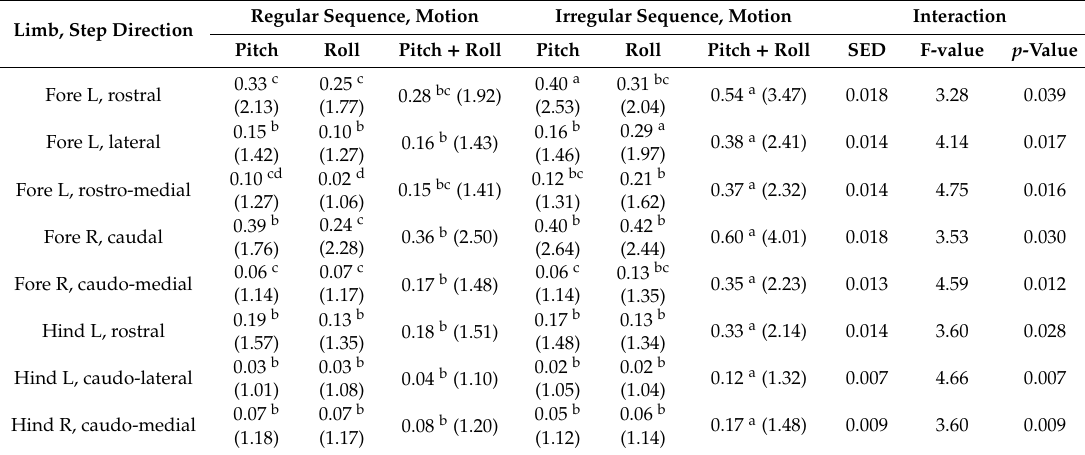
Table A4. E ff ects of regularity and type of motion on the movement patterns of the four limbs of sheep ( n = 6) subjected to motion treatments and a control. Data presented as (log 10 + 1) steps / 20 min, with back-transformed means provided in brackets. Comparisons with significantly di ff erent counts of stepping responses are presented, with these data also presented graphically in Figure 4. Di ff erent superscript letters denote significant di ff erences. (L = left and R = Right).